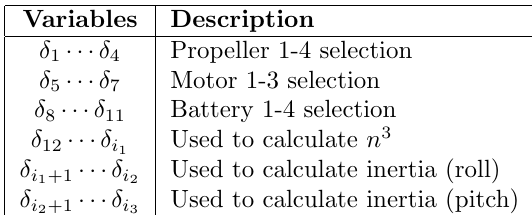
Table 1: Different candidate objective functions to be minimized/maximized depending on the re- quirement specifications.